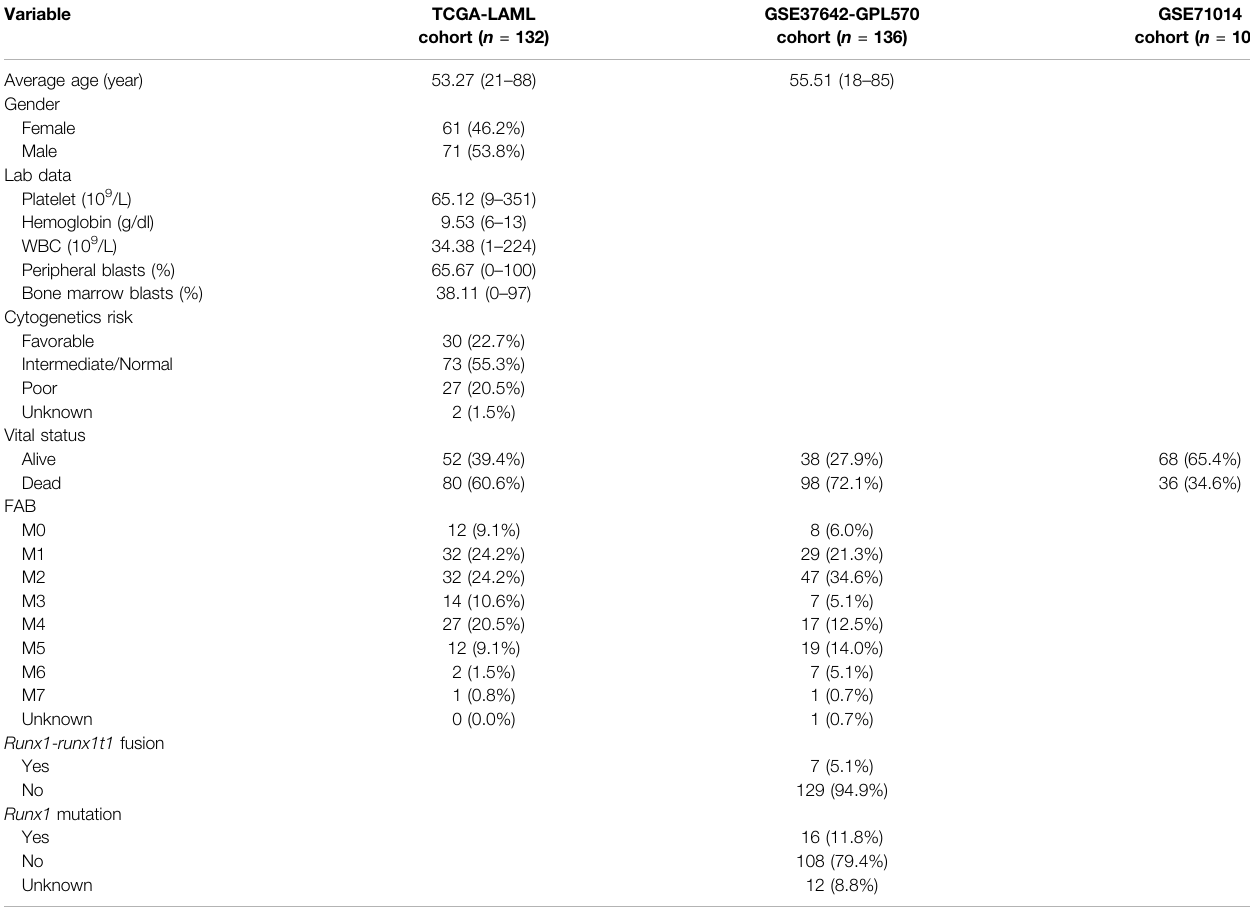
TABLE 1 | Clinical characteristics of AML patients in the three